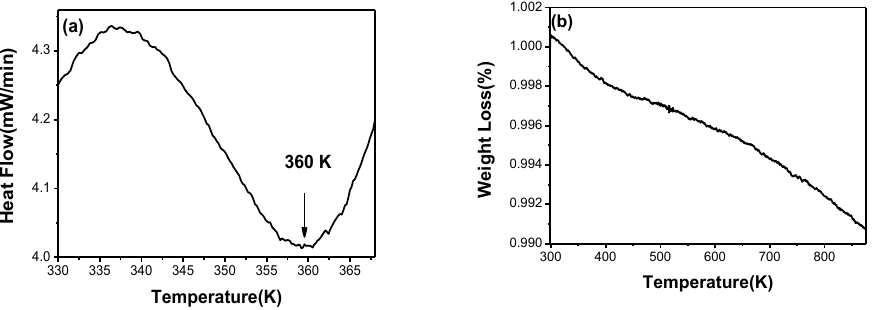
Figure 9. DSC ( a ) and TGA ( b ) curve of Sm 0.85 Sr 0.15 MnO 3- δ.